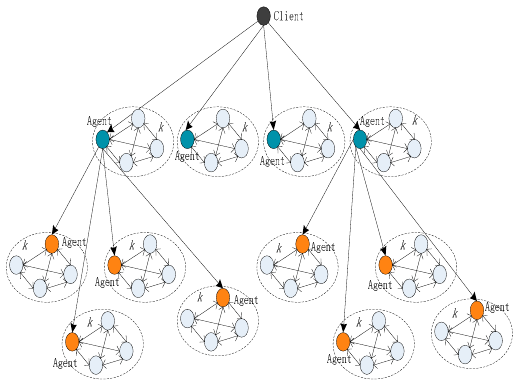
8 of 21 Figure 3. Pre-preparation process of the scalable dynamic multi-agent hierarchical PBFT algorithm. Algorithm 1. Agent-based layer for SDMA-PBFT. Input: a client node, n consensus nodes, multicast algorithm, the size of the area k Output: agreement results 1: begin